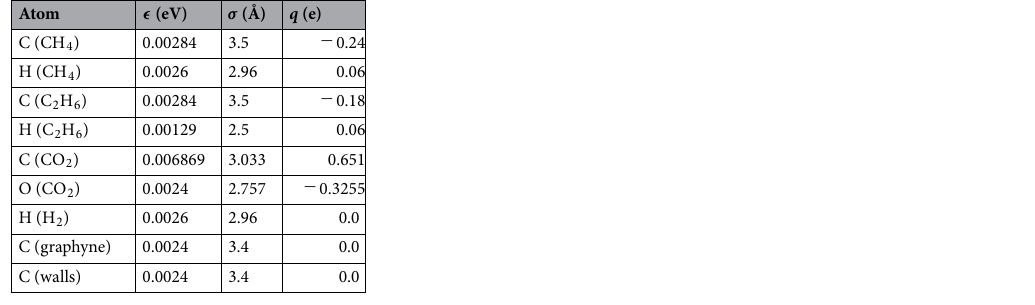
Table 1. Lennard-Jones radius ( σ ) and energy ( ǫ ) parameters, and partial charges ( q ) of the individual atoms in molecular dynamics